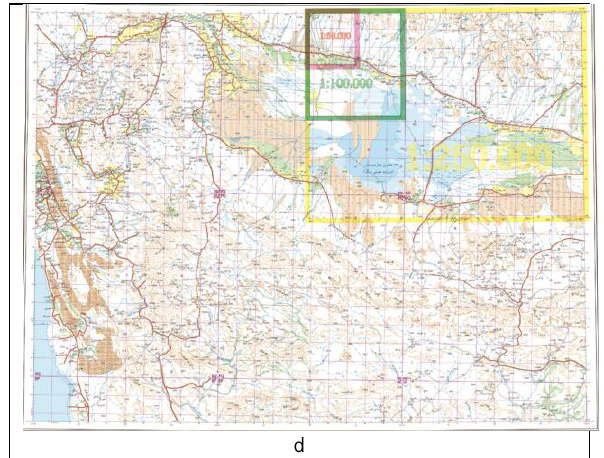
Figure 9. a: 1:50,000 base map. b: 1:100,000 generalized map, c: 1:250,000 generalized map. d: 1:500,000 generalized